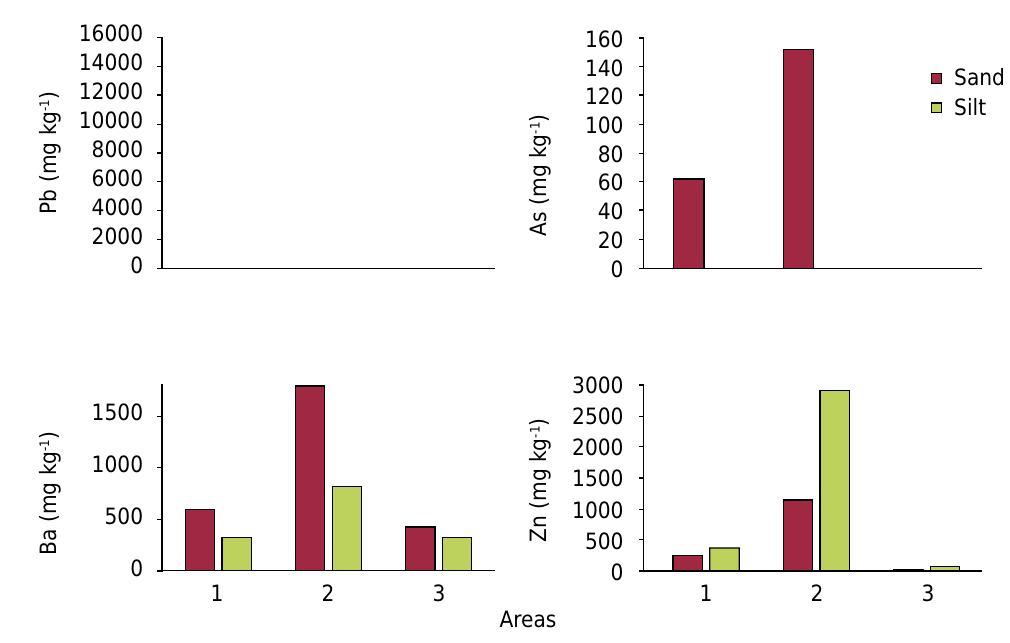
Figure 4. Average of total contents of Pb, As, Ba, and Zn in sand and silt fractions in areas 1, 2, and